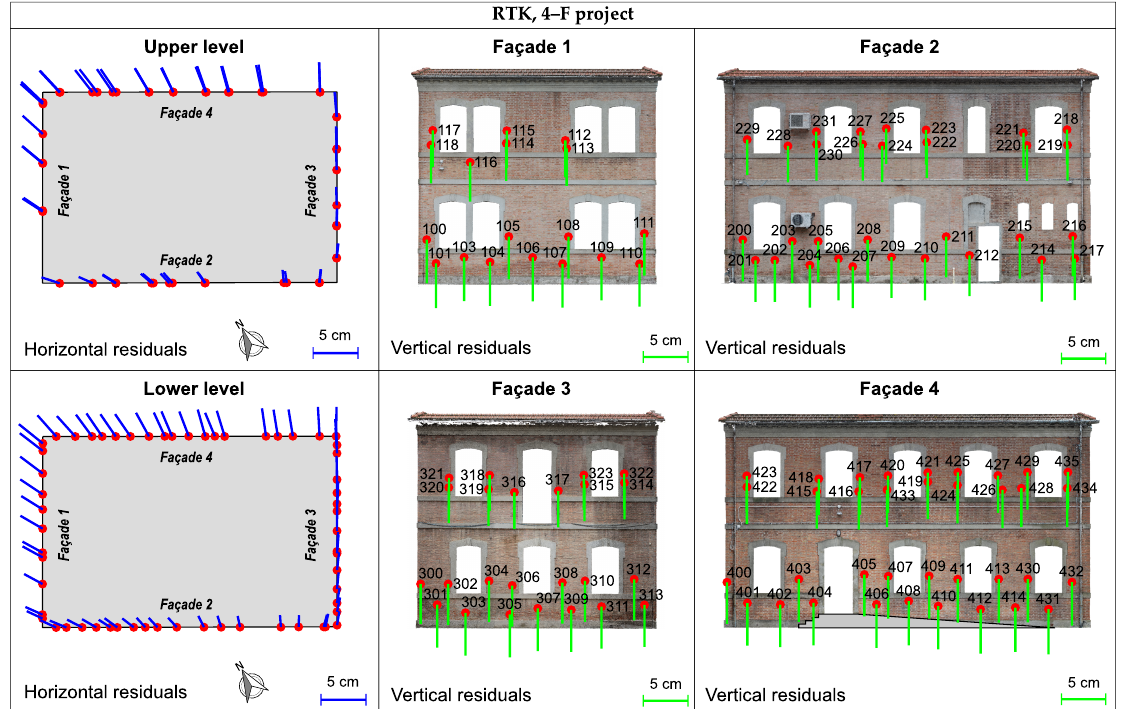
Figure A3. Horizontal and vertical residuals for RTK image dataset processed as an overall block